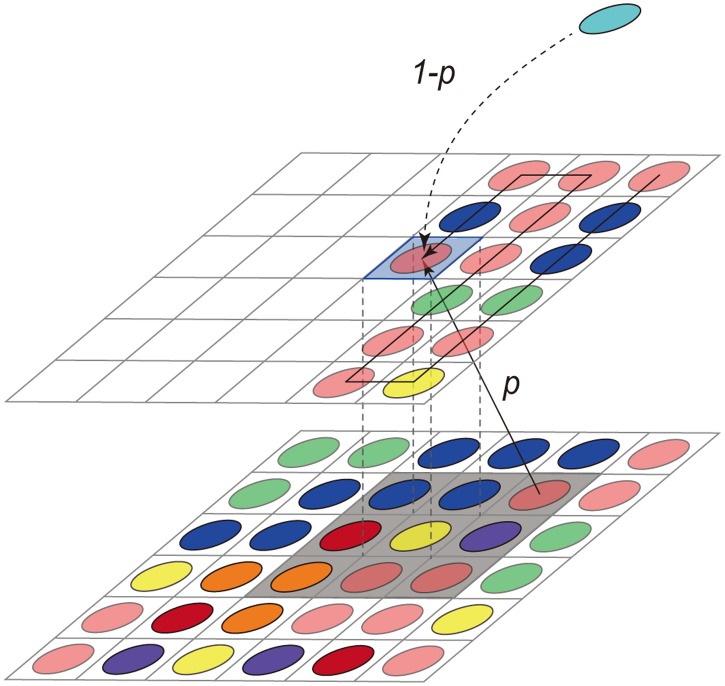
Concept of the mathematical model.To determine the species in the blue-shaded lattice (top), a species in the black shaded area (underneath) is randomly selected with probability p. A new additional species joins with probability 1-p.